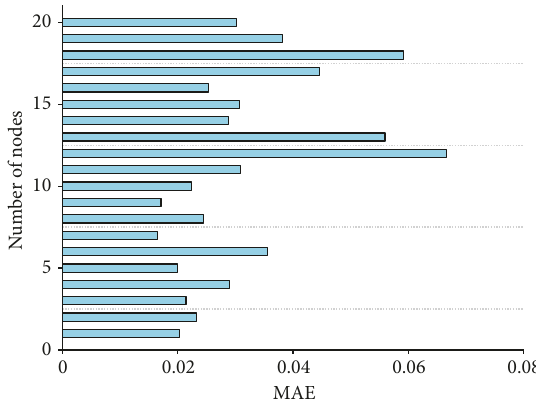
Figure 12: Neural node optimization of double-hidden layer BP.